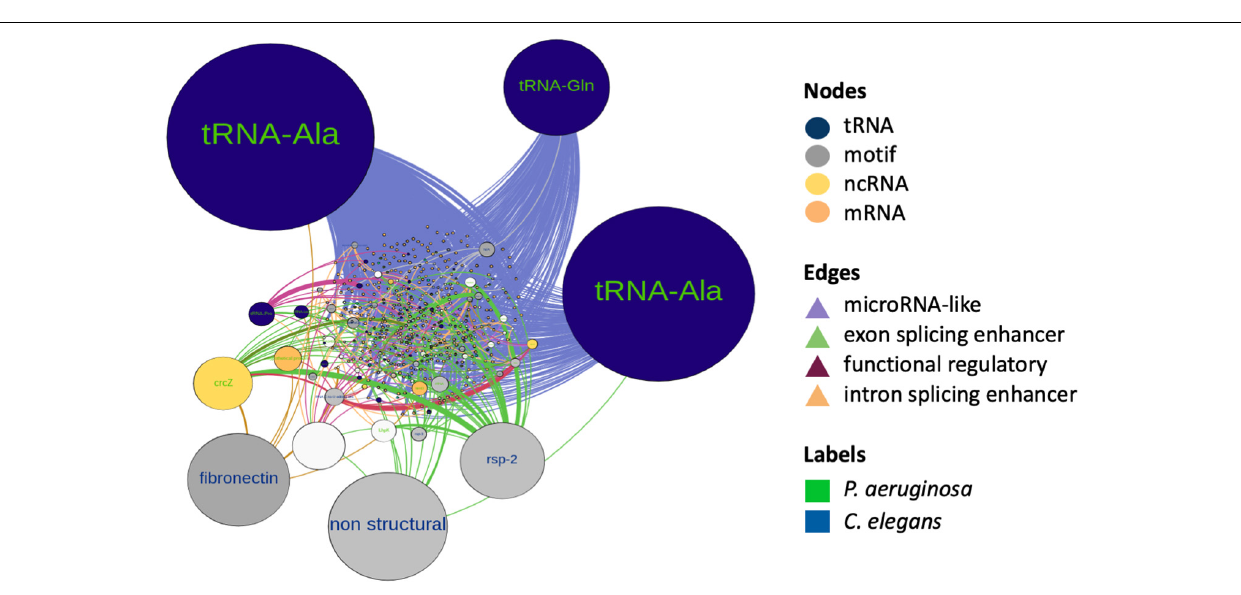
FIGURE 6 | RNA interactome network of cross-kingdom predictions between bacterial non-coding sRNAs and host sRNAs and long non-coding RNAs and coding RNA candidate targets. Node colors represent biotypes and are differentiated by organisms. Nodes are scaled by size according to their betweenness centrality. The edges represent predicted interactions of this work and are colored according to the putative